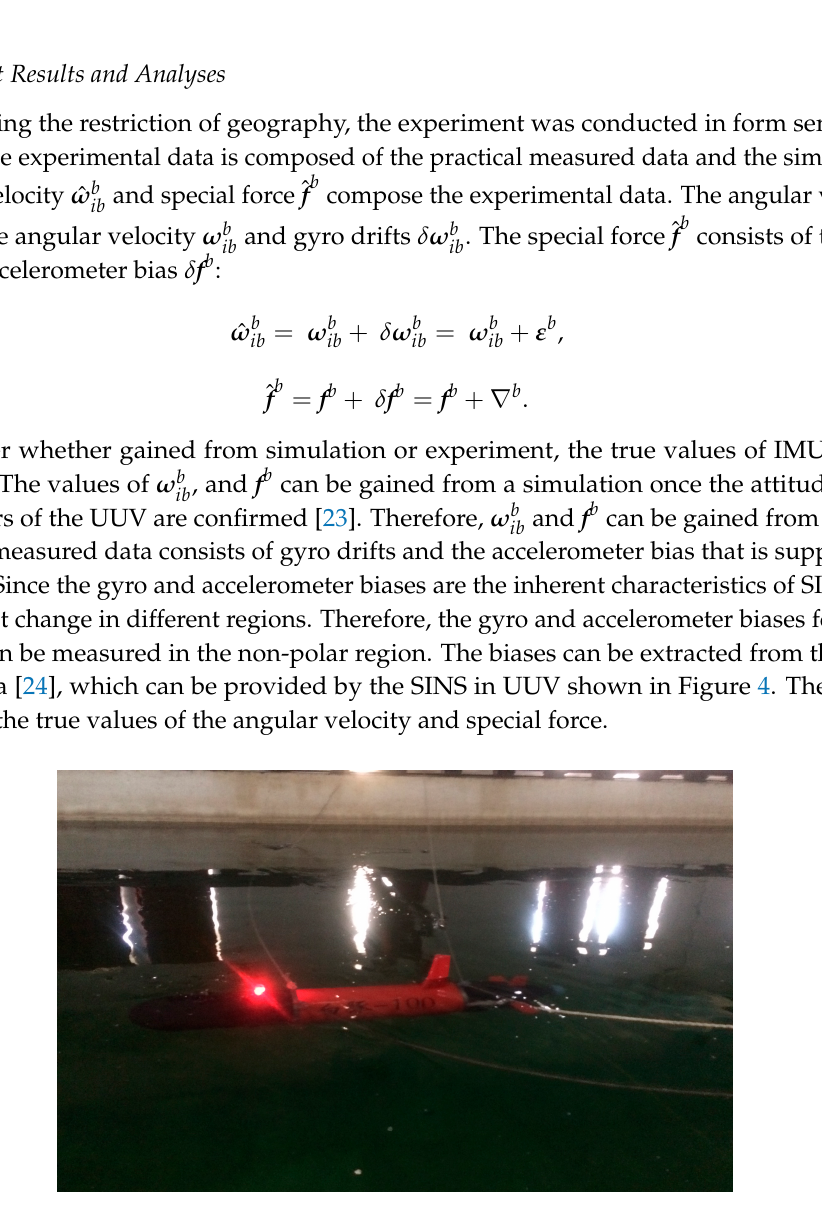
Figure 4. Unmanned Underwater Vehicle during the experiment.